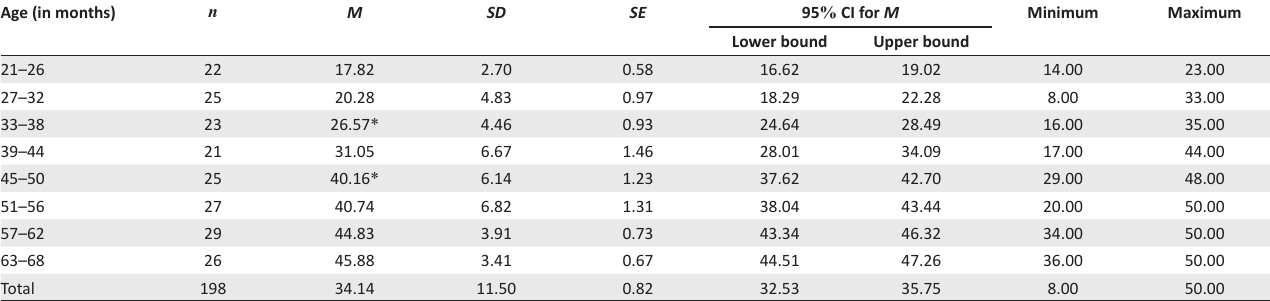
TABLE 8: Expressive language Mullen Scales of Early Learning raw scores, standard deviations, confidence intervals and the range of scores for each age group. Age (in months) n